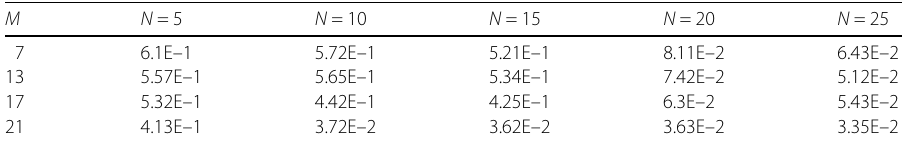
(cid:5) , S Table 1 Error of results Y 0 for example M N = 5 N = 10 N = 15 N = 20 N =